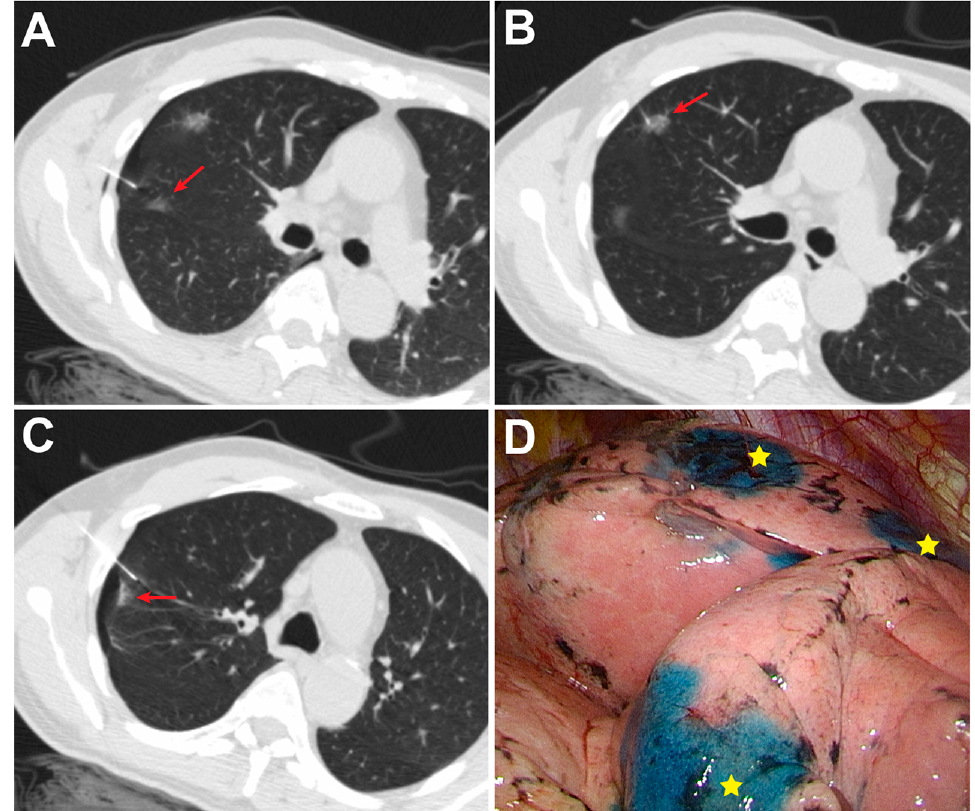
Figure 1. ( A , B ) Localization via simultaneous puncture with patent blue dye (PBD) injection of two subsolid nodules (arrows) was performed in a 58-year-old female in the lateral decubitus position; ( C , D ) The stained areas on the visceral pleura were obviously identified during video-assisted tho- racoscopic surgery (VATS). These two nodules were proved to be invasive adenocarcinomas.